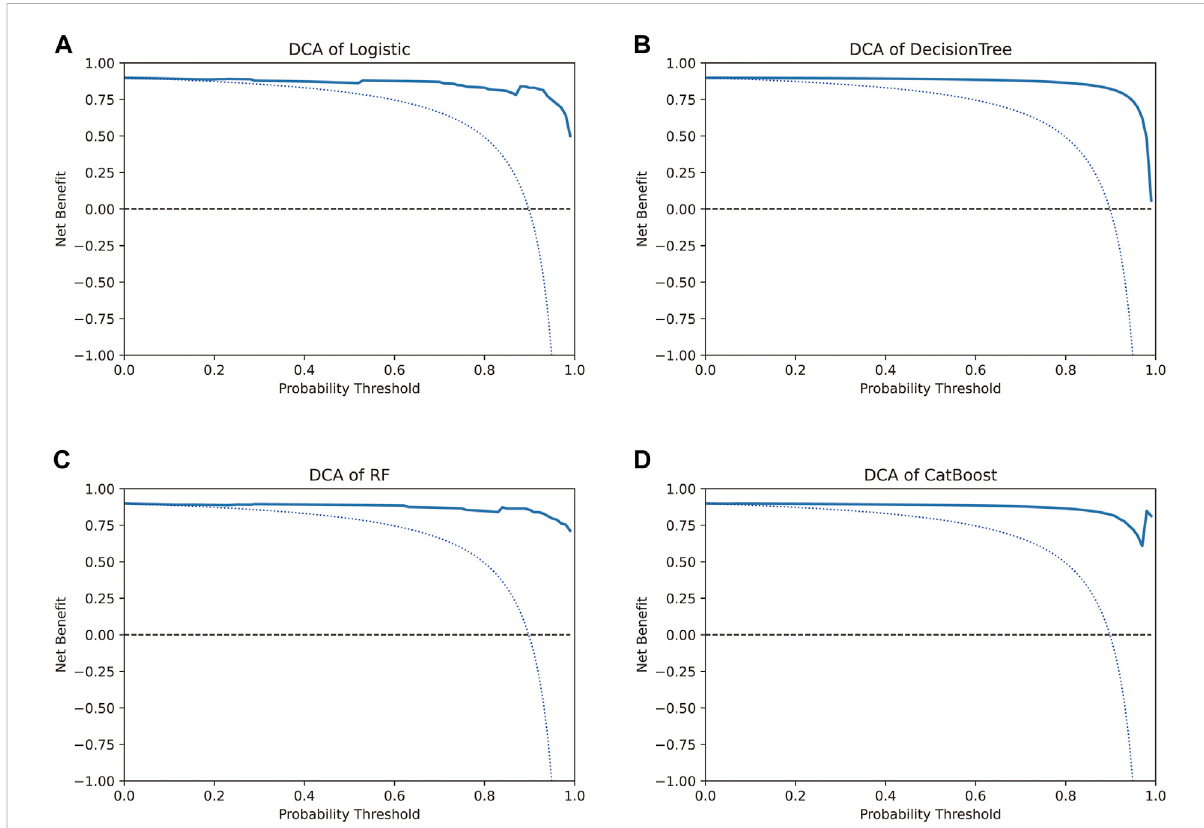
FIGURE 5 Decision curve analysis to evaluate the bene fi t of prediction models. The two dotted lines re fl ecting the strategies of “ assume all patients have strategies ” (i.e., treat all) and “ assume no patients have strategies ” (i.e., treat none) cross at the midpoint of the preference range. In the CatBoost model,ahighnetbene fi twasobservedacrossawiderangeofthresholdprobabilities,whereastheotherthreemodelsshowedasigni fi cantdecrease in net bene fi t when the threshold probabilities were greater than